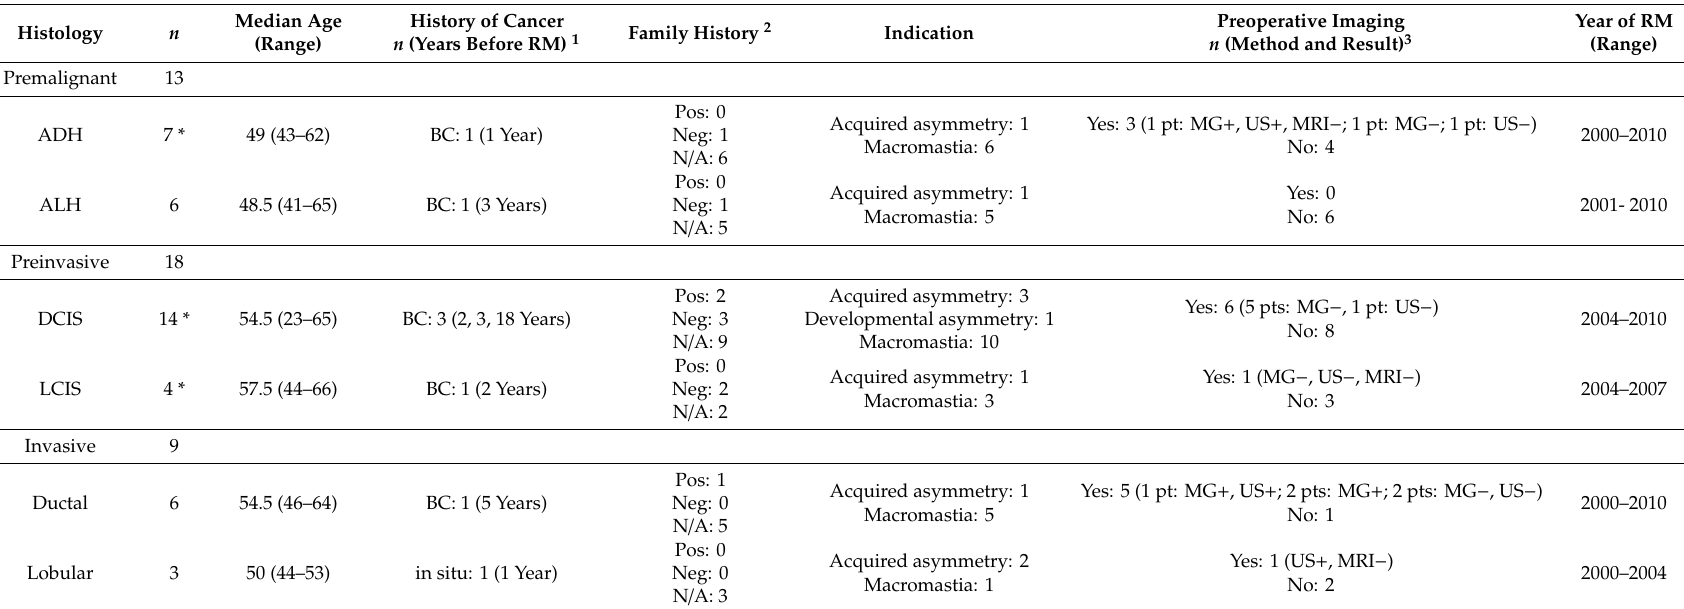
Table 4. Baseline characteristics of patients with pathological